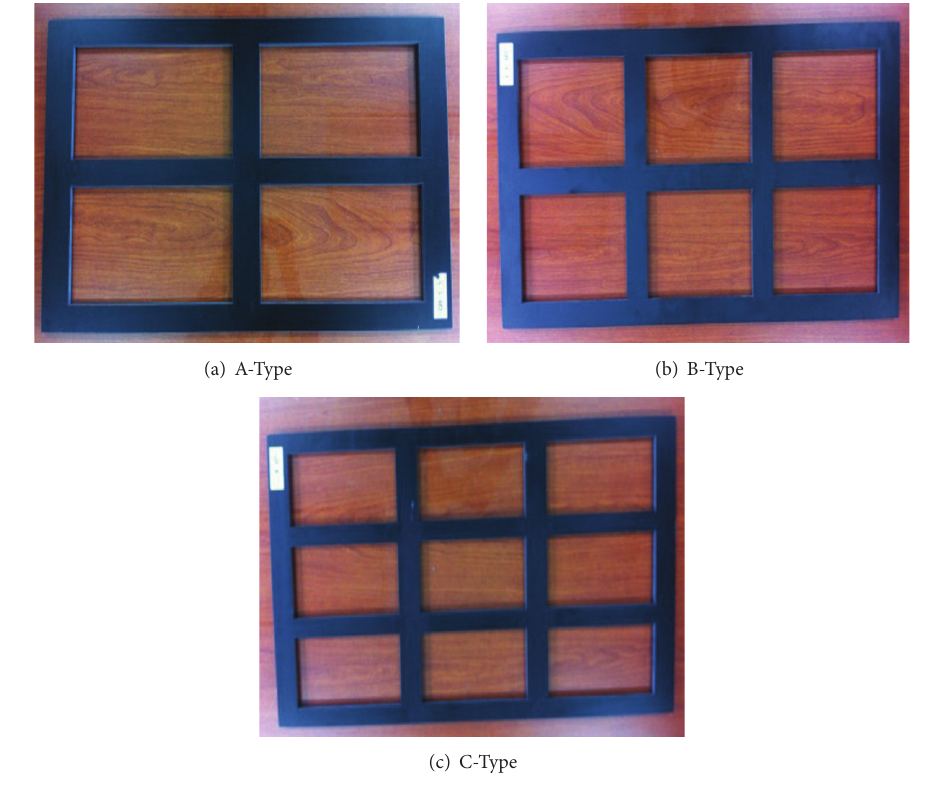
Figure 2: Designs of the three experimental GFRP plates.